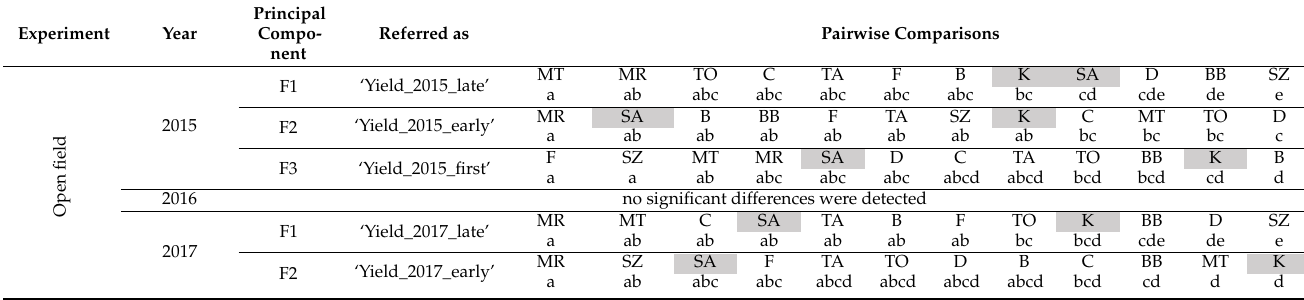
Table 7. The post hoc test results of the significant PCs obtained from the yield data of the different tomato gene bank items and control varieties regarding the open-field experiment. Different letters from lower to higher yields represent significantly different groups (Games-Howell’s, p < 0.05). Abbreviations of the Hungarian gene bank items are: B: ‘Balatonbogl á r’; C: